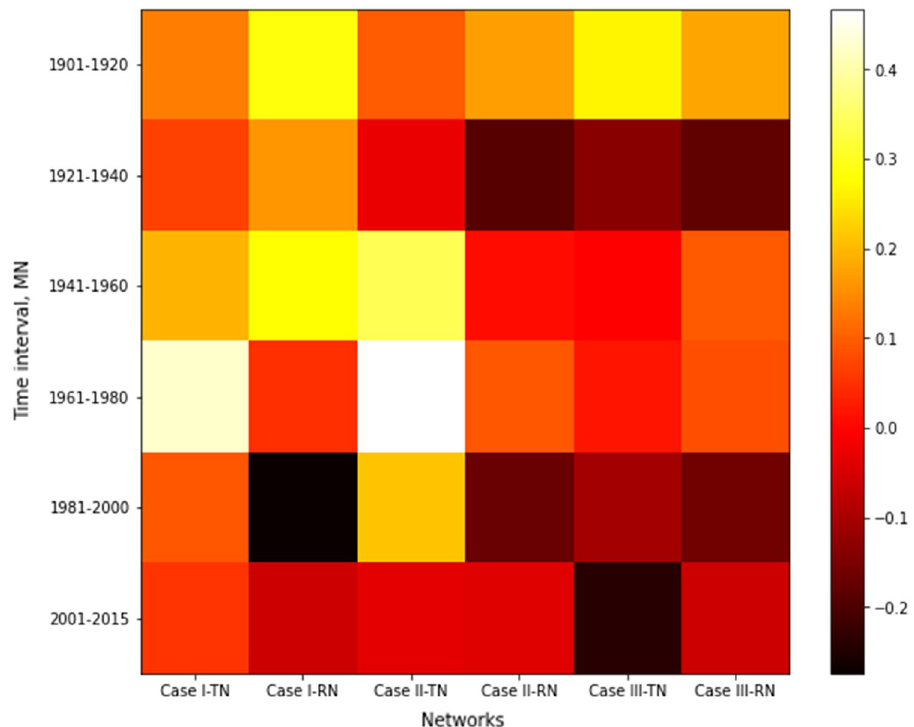
Figure 2. Degree correlations between three networks: temperature network (TN), rainfall network (RN), and incidence of malaria network